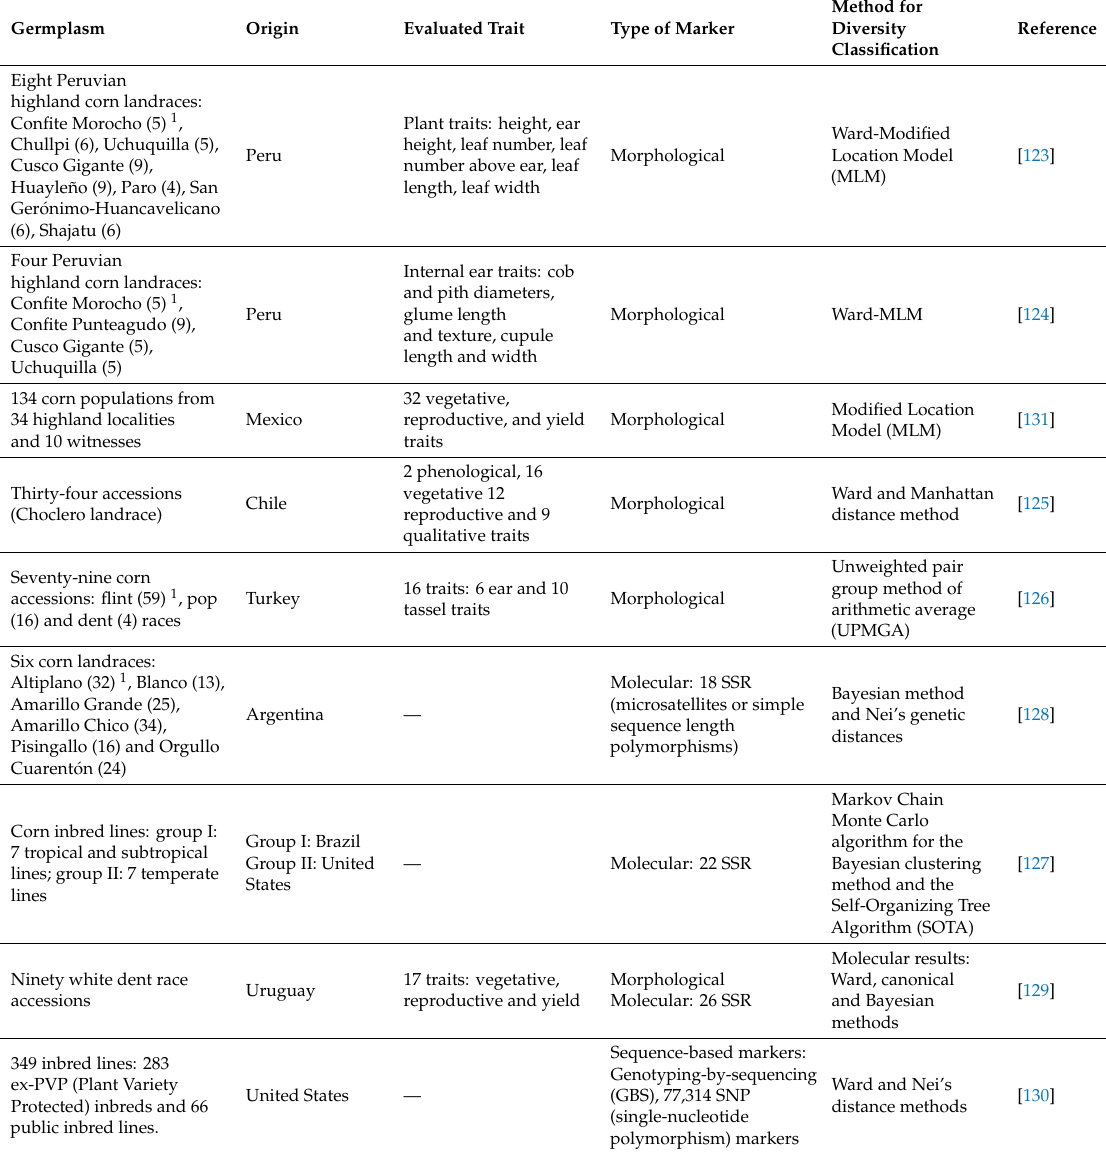
Table 5. Investigations about the corn genetic diversity using di ff erent types of markers.